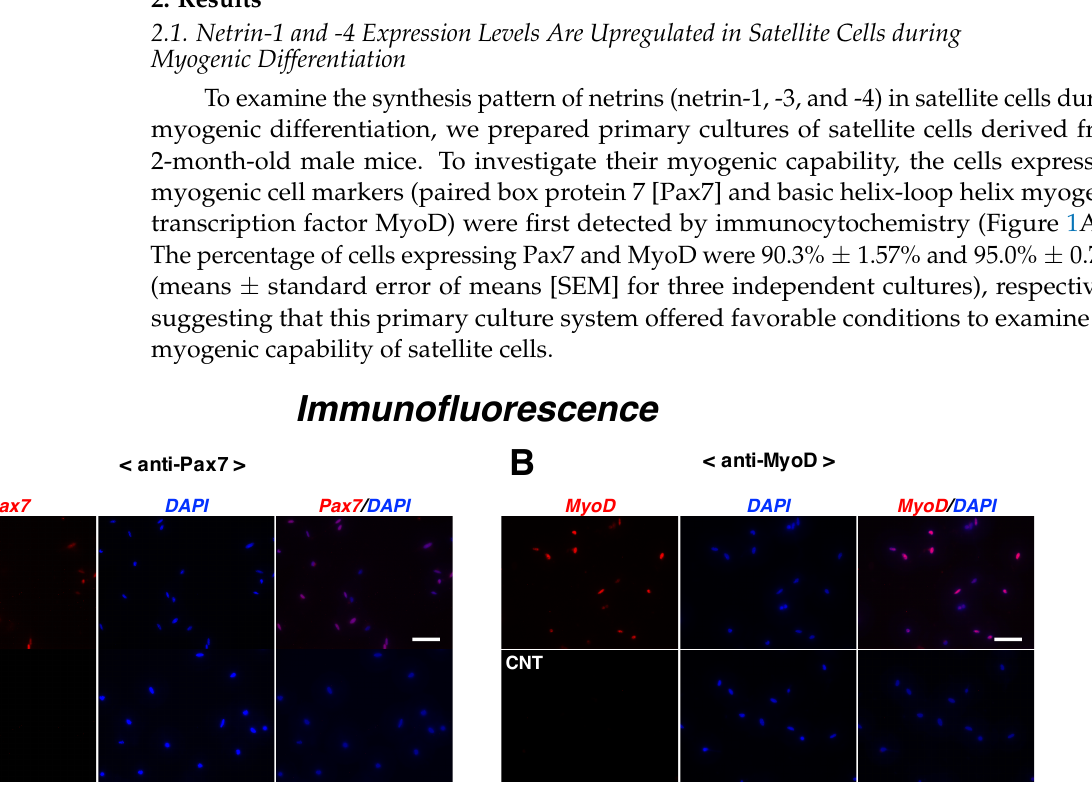
Figure 1. Myogenic capability of satellite cells. ( A , B ) Satellite cell primary cultures isolated from the back, buttock, and upper hind limb were maintained for 24 h in F-10–20% FBS medium and evaluated for the ratio of cells expressing each myogenic protein. Immunofluorescence microscopy for Pax7 (panel A ; red) or MyoD (panel B ; red) and DAPI (blue) showing satellite cells and nuclei. CNT , control cells stained without primary antibodies. Scale bar in panels ( A , B ), 50 µ